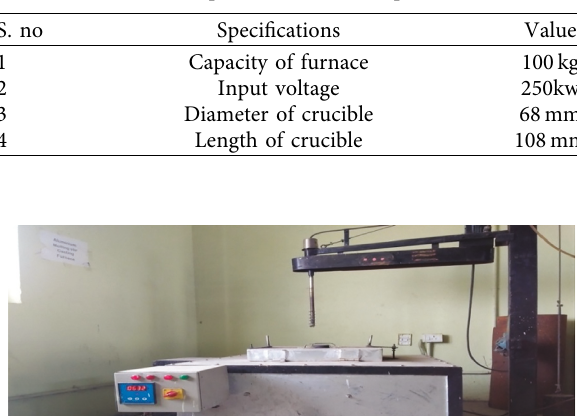
Figure 8: Crucible placed in furnace. Table 1: Specifications of components.